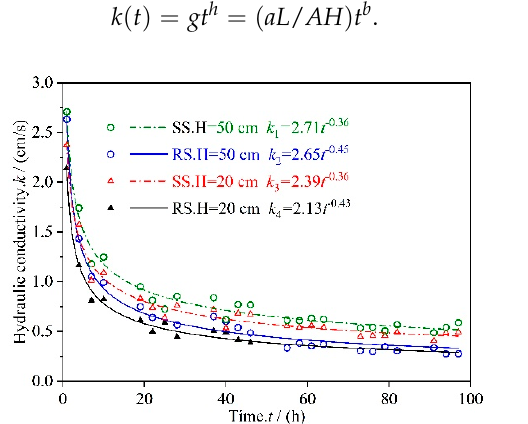
Figure 9. Changes in the permeability coefficient for RS and SS series of microporous ceramic filter membranes with respect to time.